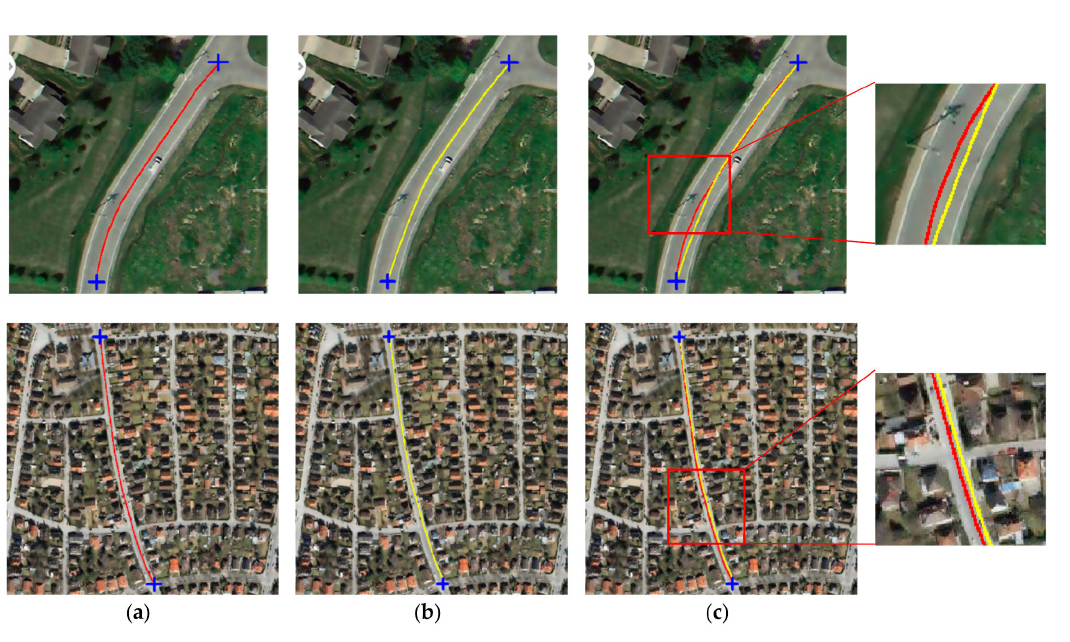
Figure 3. Comparison of the results of road centerline extraction. ( a ) Red represents the result obtained with edge constraint; ( b ) Yellow represents the result obtained without edge constraint; ( c ) Superimposition of the two results. Seed points are shown as blue